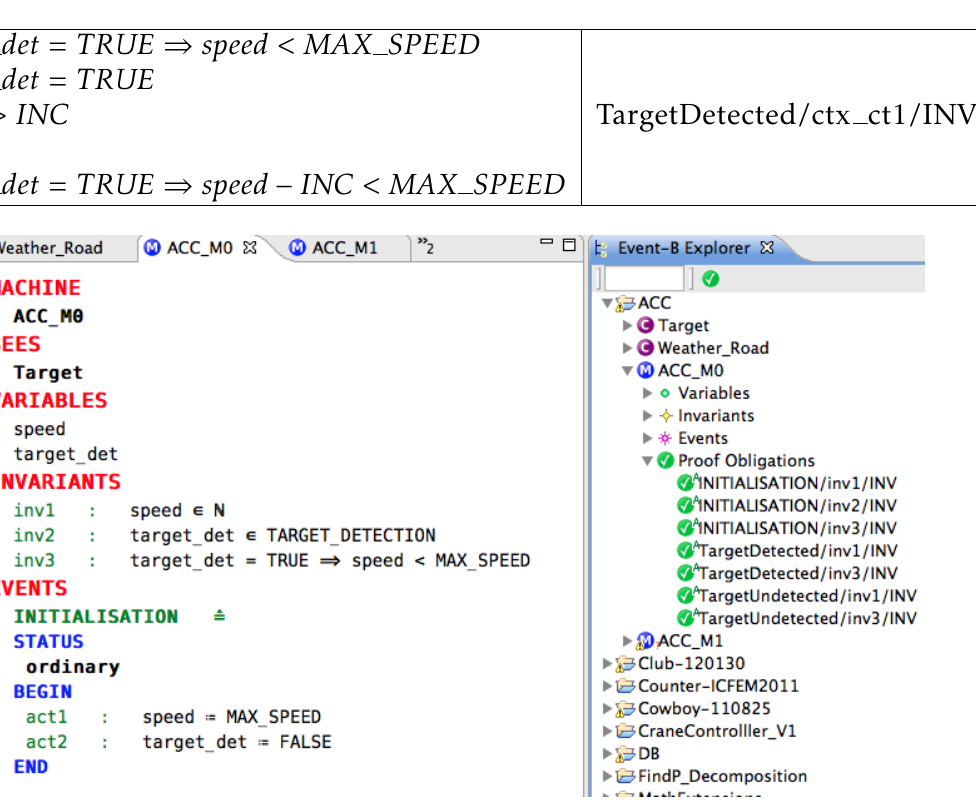
Table 3. Proof of context constraint preservation